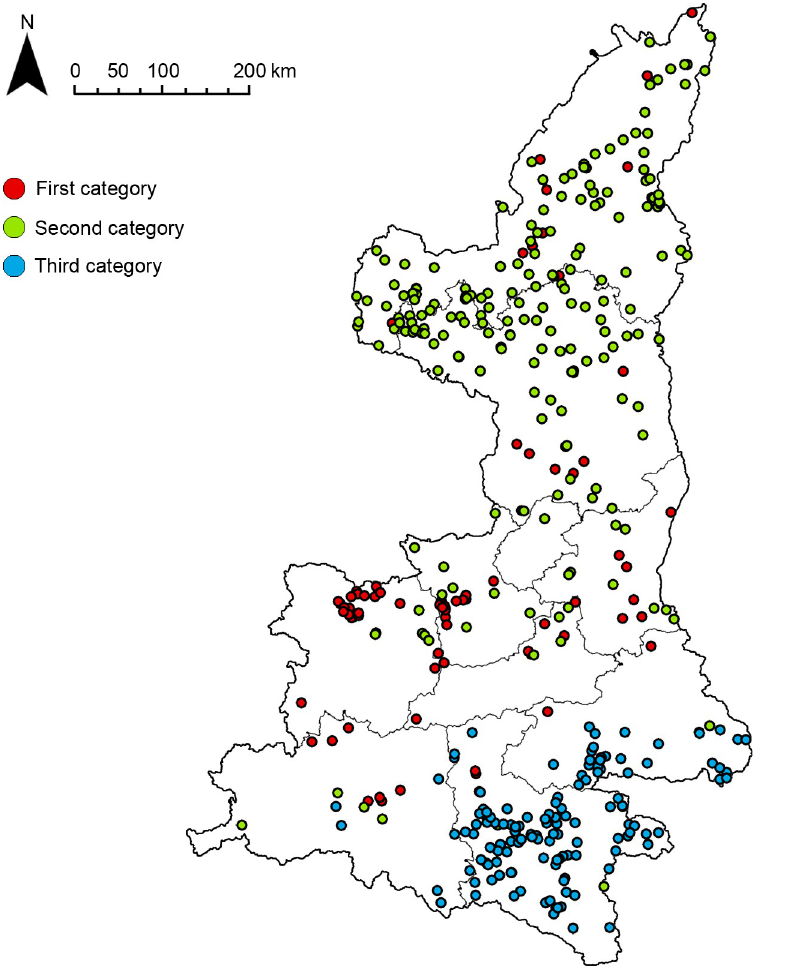
Fig 7. Cluster distribution